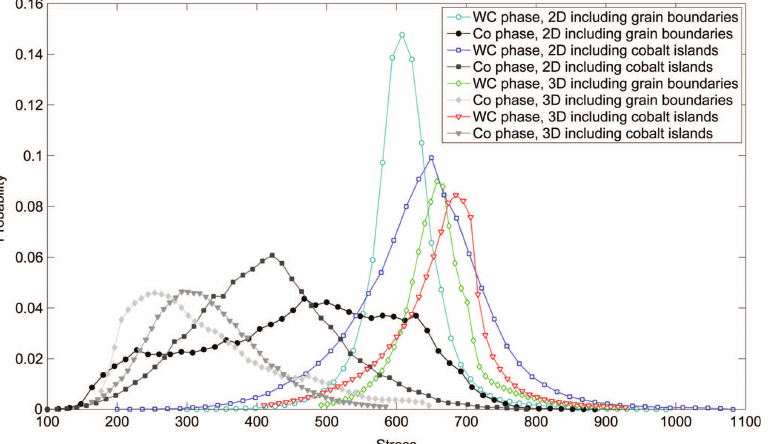
Figure 17: Distributions of the stresses σ 11 in the individual material phases for the material with 9% of cobalt with respect to different modelling